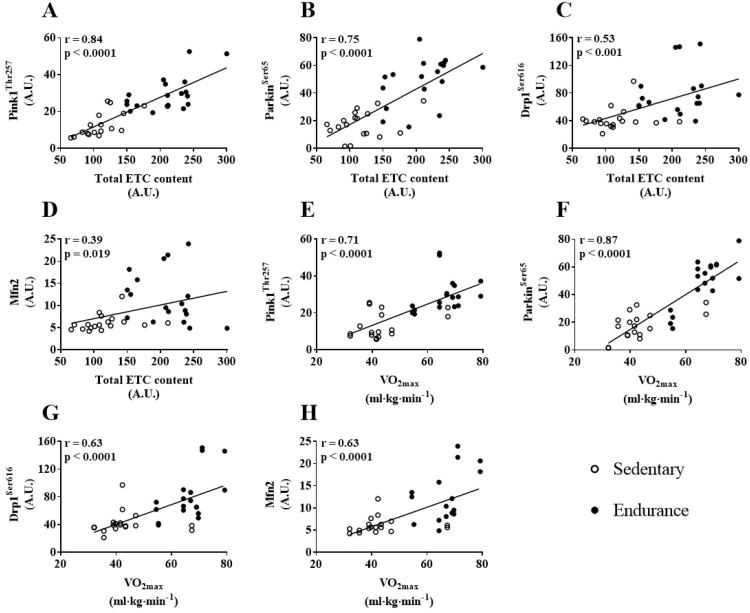
Correlations between skeletal muscle total ETC protein content and maximal oxygen consumption (VO2max) compared to content of mitophagy and mitochondrial dynamic proteins. (A&B) total ETC protein content and phospho-Pink1Thr257, (C&D) VO2max and phospho-ParkinSer65, (E&F) VO2max and phospho-Drp1Ser616, (G&H) VO2max and Mfn2. Correlations with protein data were based on fasted and post-HFM data points.